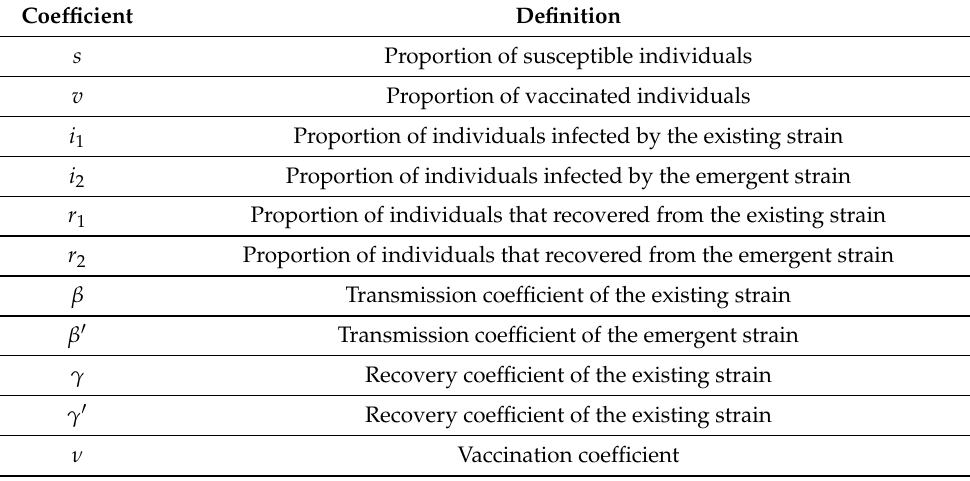
Table A1. The transition coefficients of the modified multi-strain SIR